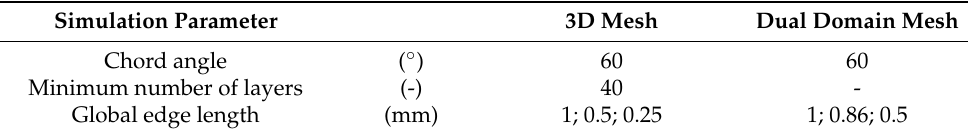
Table 5. Simulation parameters.